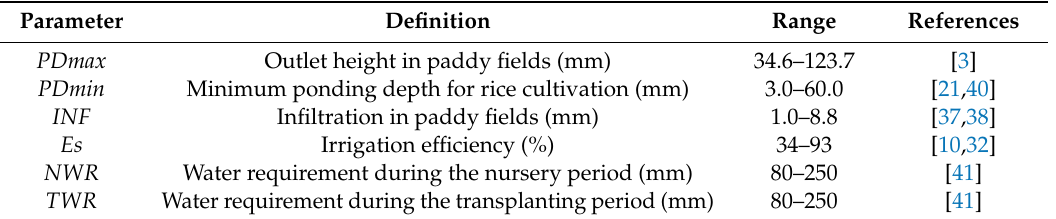
Table 1. Range of calibration parameters for agricultural water supply